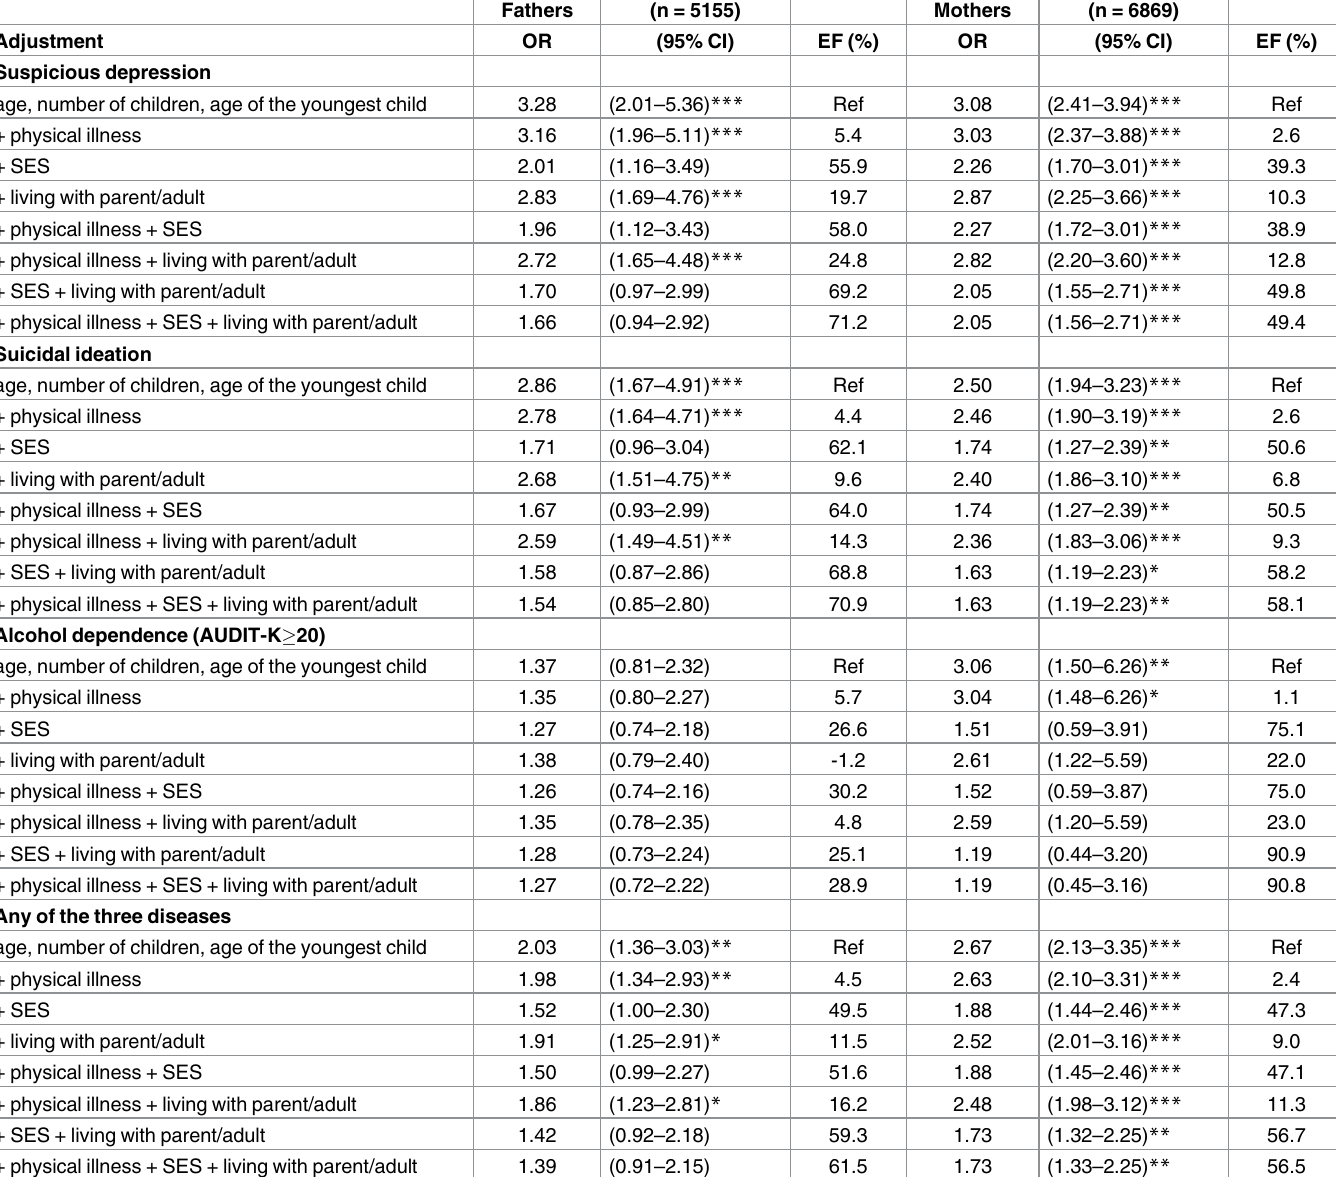
Table 3. Odds ratios of poor mental status for single parents compared to partnered